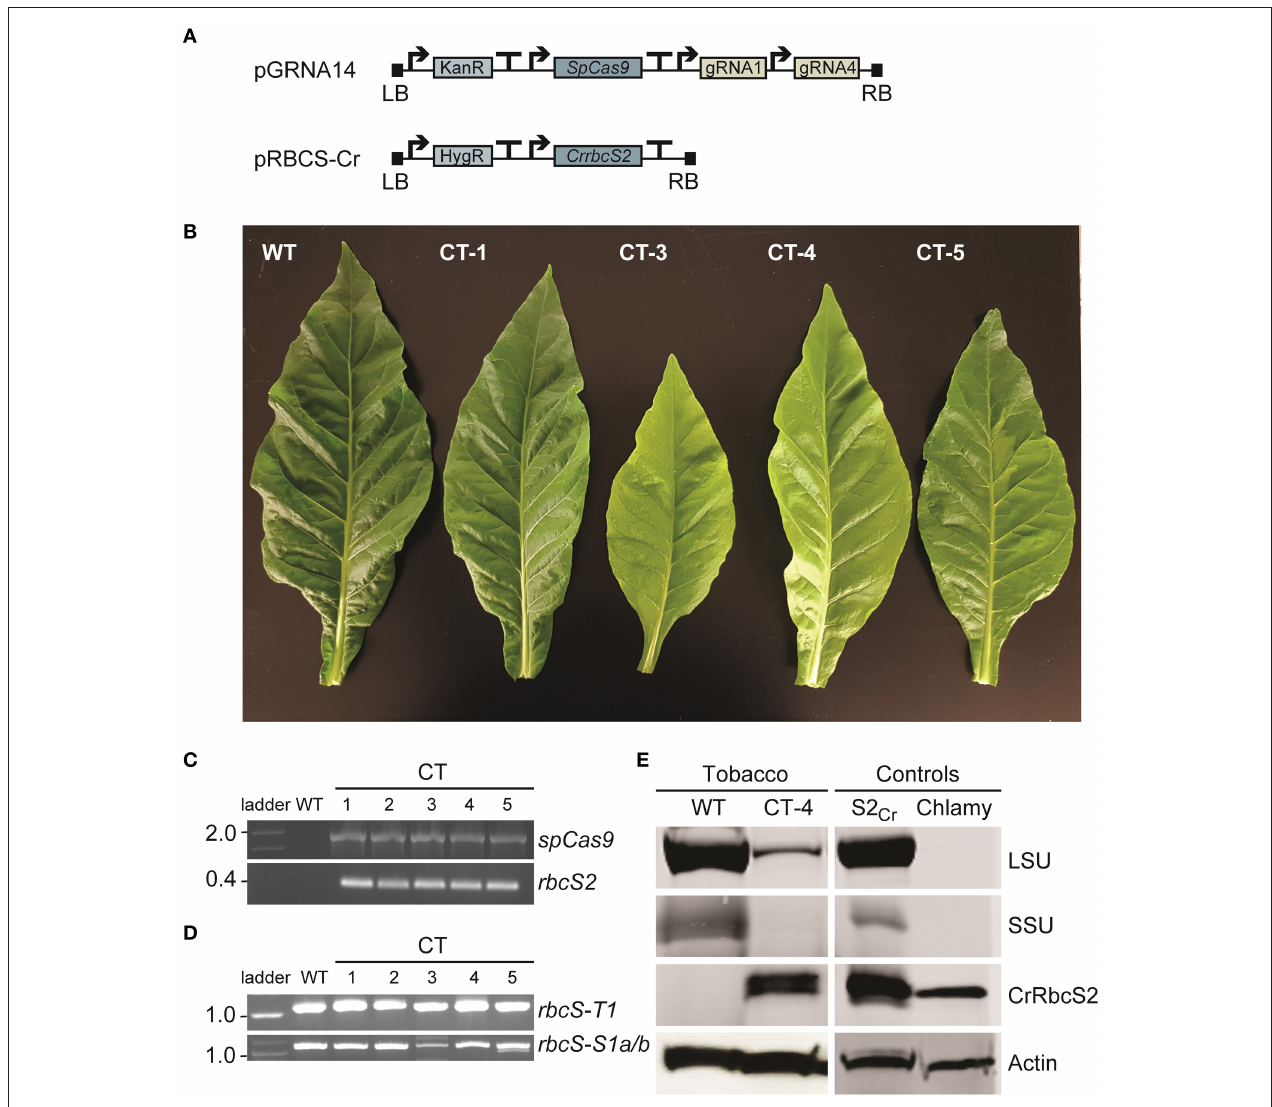
FIGURE 5 | Phenotypes and molecular analyses of co-transformed (CT) plants. (A) Wild-type plants were transformed with a Cas-gRNA vector (vector pGRNA14) and gene expression cassette for CrrbcS2 from Chlamydomonas (vector pRBCS-Cr) (see Supplementary Figures 1, 2 for vector details). (B) Leaves of a wild-type (WT) plant and four CT lines with phenotypes ranging from wild-type-like (CT-1) to pale (CT-3 and CT-4) and chimeric (CT-5) are shown. (C) PCR amplification of cDNA showing stable integration and expression of SpCas9 and rbcS2 in T 0 CT lines. (D) PCR amplification of rbcS-T1 and rbcS-S1a/b (as in Figure 2B ). (E) Immunoblots of total soluble protein to detect the Rubisco large subunit (LSU) and small subunit (SSU) from tobacco and SSU from Chlamydomonas (CrRbcS2) in CT-4 (T 1 generation). The two controls were from Arabidopsis expressing CrRbcS2 (S2 Cr ; Atkinson et al., 2017) and Chlamydomonas. An actin loading control is shown. No LSU and SSU bands were visible for the Chlamydomonas extract using the primary antibody against wheat Rubisco.